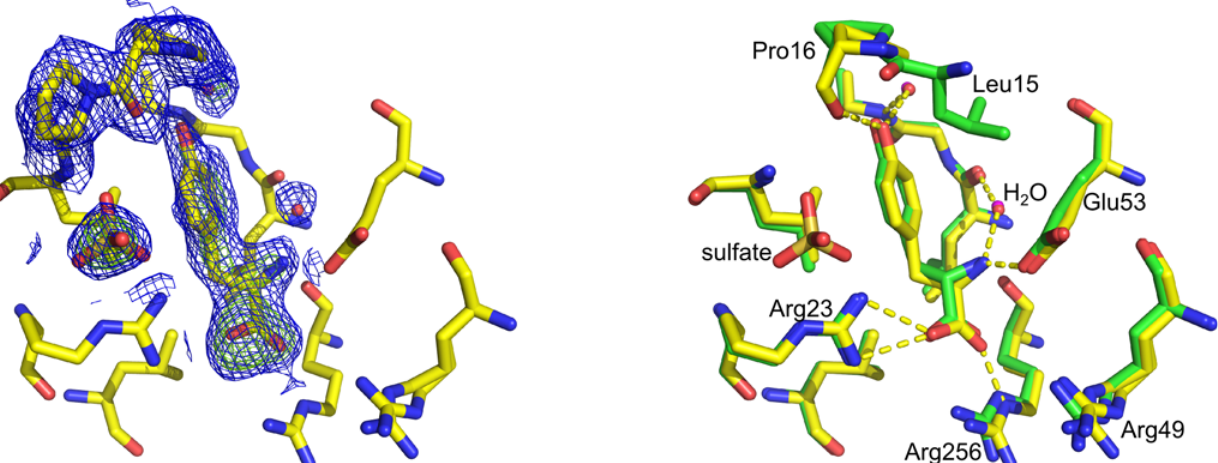
Fig 6. D -Tyr in the Tyr site (pdb id 5E4N). Left: Part of the electron density map in site 3 with D -Tyr bound. The model conformation for the Pro16 loop is in good agreement with the map, the omit map shows the density for D -Tyr, water molecules and a sulfate ion. 2Fo-Fc map contoured at 1.0 σ (blue mesh) and Fo-Fc omit map contoured at 3.0 σ (green mesh). Right: Comparison of L -Tyr (green sticks, water molecules shown as magenta spheres) and D -Tyr (yellow sticks, water molecules shown as red spheres) binding mode in the Tyr site. The sulfate ion is shown in gold (sulfur) and red (oxygen).